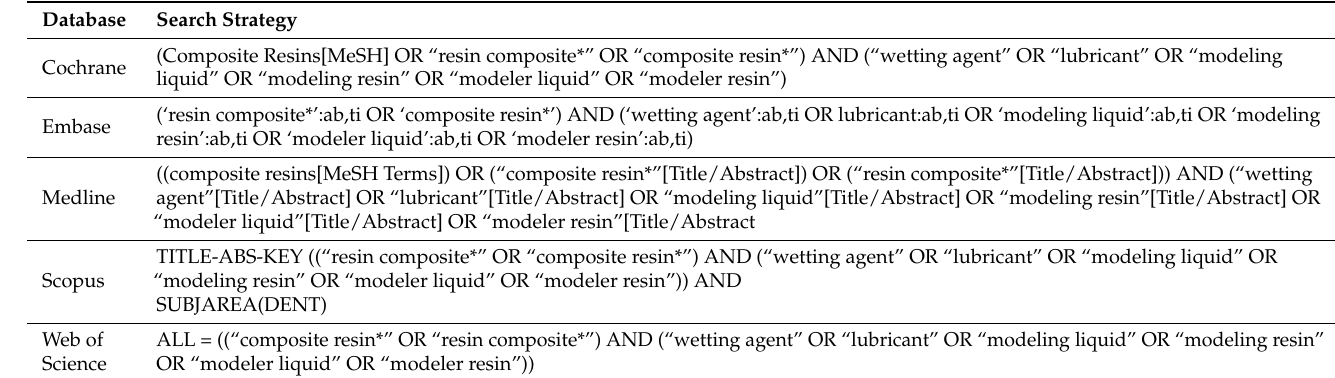
Table 2. Search strategy as conducted per each database.